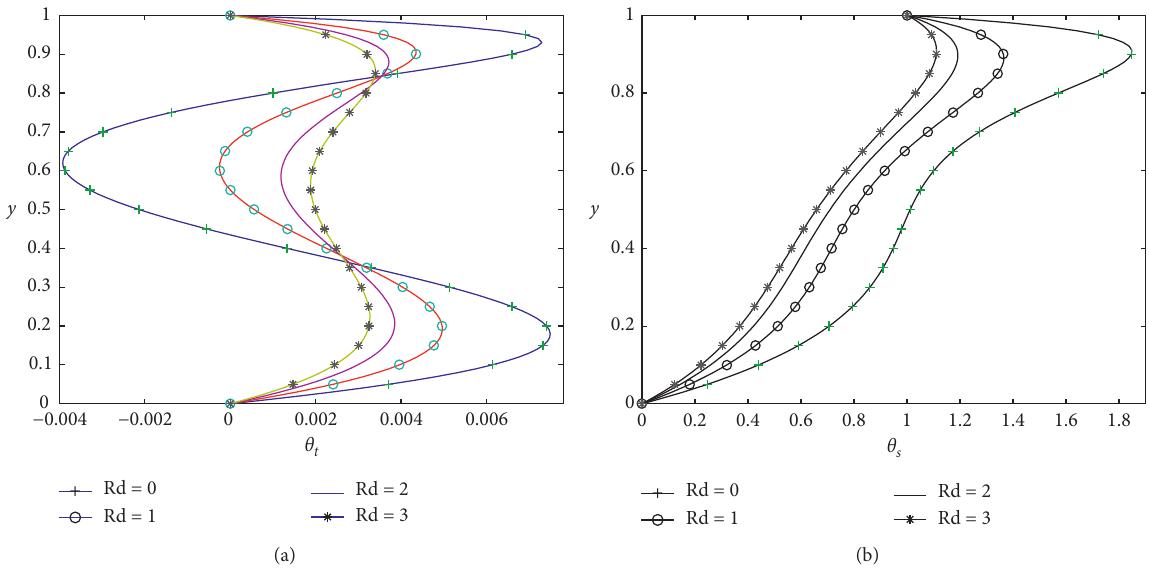
Figure 5: Effect of Rd on (a) unsteady and (b) steady temperature distributions when t � π /4 , ε � 0 . 01 ,H � 3 , β � 2 , Ec � 1 , Q � 0 . 5 , Da � 0 . 1 , M � 0 . 5 , Re � 1 , Pr � 21 , and ϕ � 0 .